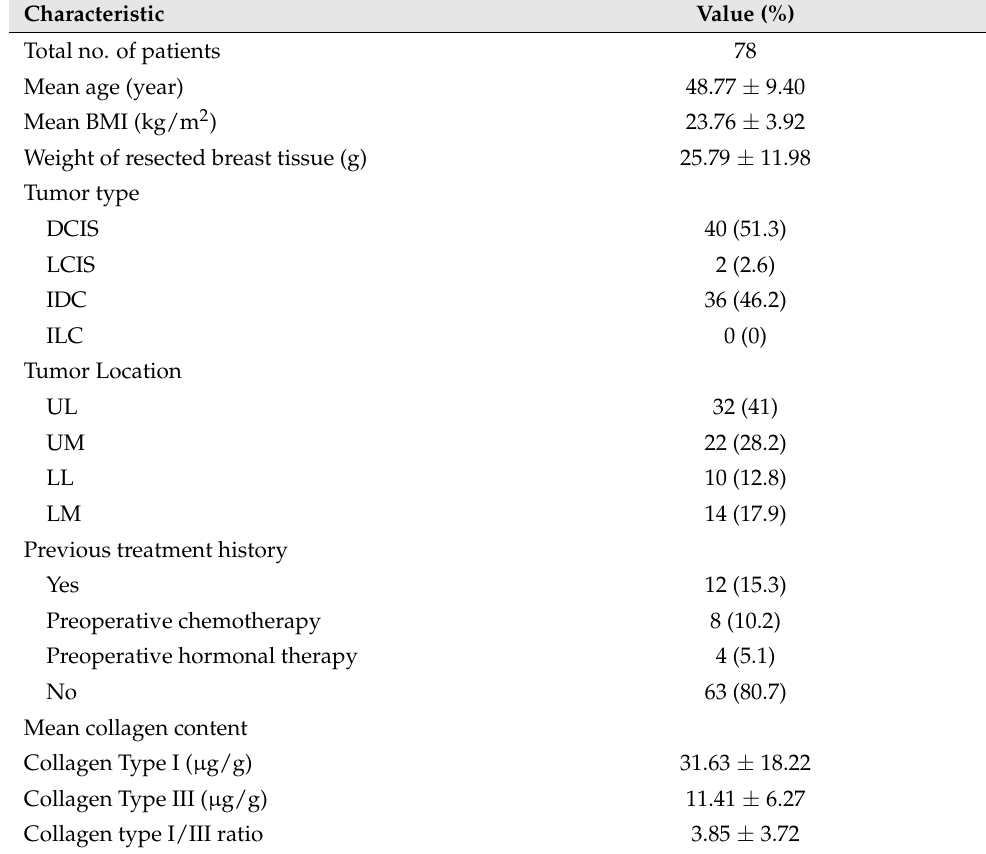
Table 2. Baseline patient characteristics.